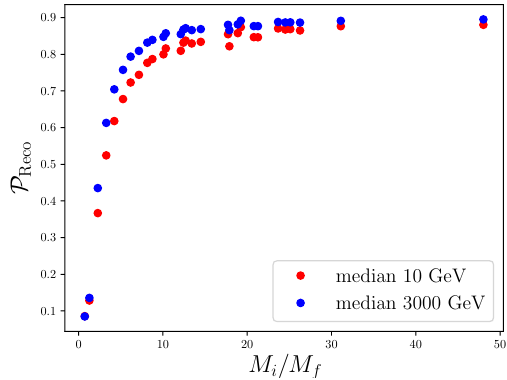
Figure 15 . Parametrisation of the reconnection probability for two cluster evolution in terms of the ratio of invariant cluster masses M i =M f , where M i is the sum of invariant cluster masses of the initial colour (cid:13)ow and M f is the sum of invariant cluster masses of the alternative colour (cid:13)ow of a two cluster